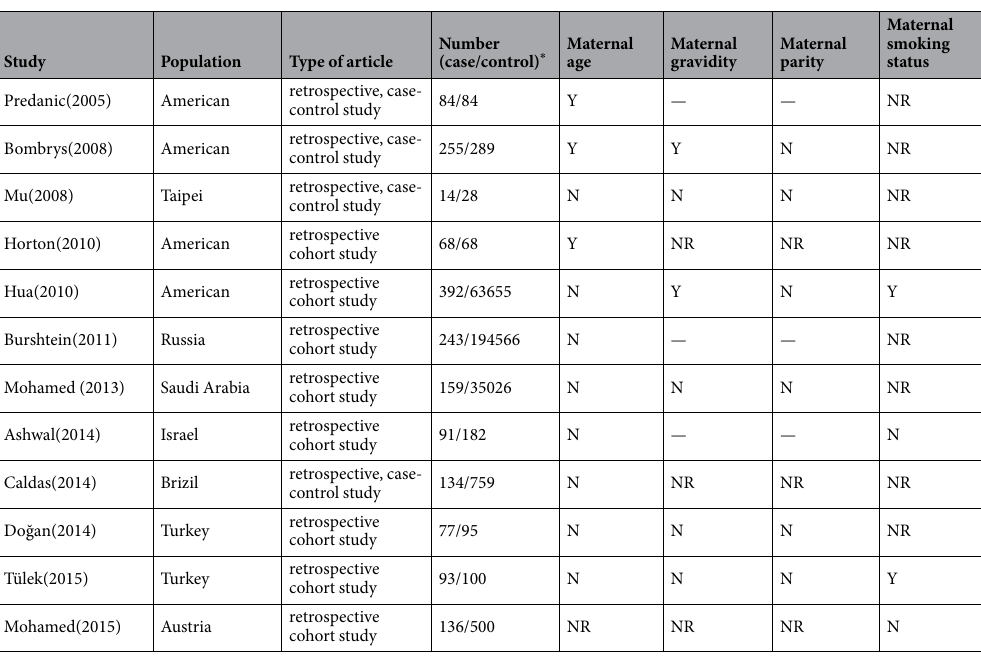
Table 1. Summary of studies and the risk factors of isolated SUA included in the meta-analysis. * Case/ control = isolated SUA / normal umbilical artery. NR: no refer. “ − ”: not available; Y: indicates that the factor is a risk of isolated SUA in this study. N: indicates the factor is not a risk of isolated SUA in this